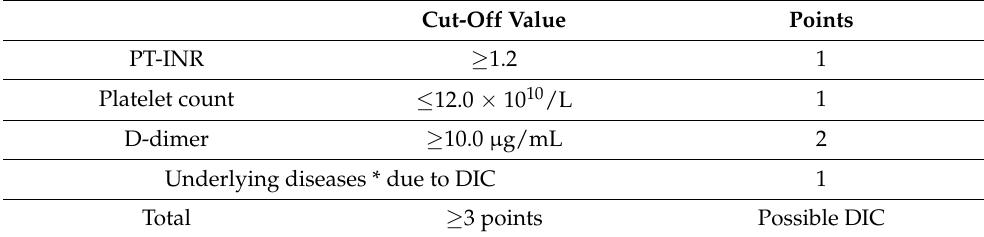
Table 4. Quick DIC diagnostic